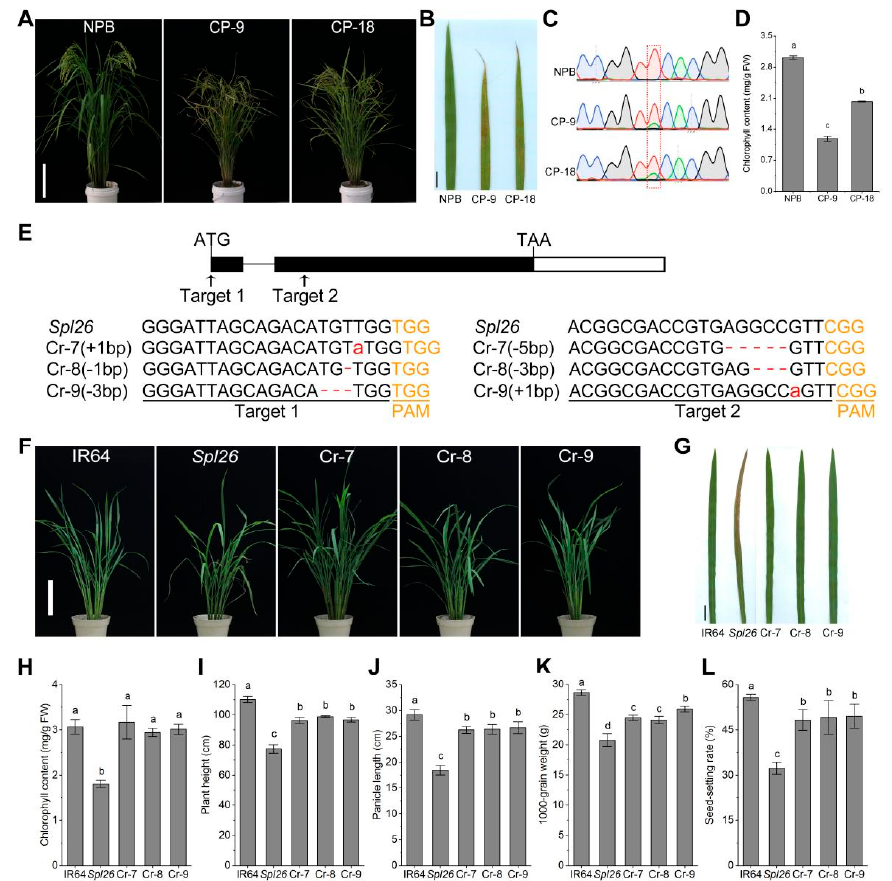
Figure 1. Reverse functional complementation and characterization of reverse complementary and knockout lines. ( A ) Phenotypes of wild-type Nipponbare (NPB) and reverse complementary lines CP-9, CP-18 at the heading stage. Bar = 17 cm; ( B ) Leaf phenotype of NPB and reverse complementary lines. Bar = 2 cm; ( C ) Genotype of NPB and reverse complementary lines CP-9, CP-18. The red box represents the mutation site, NPB has a single red peak (T), both CP-9 and CP-18 have a red/green double peak (T/A). Red peak indicates T, Blue peak indicates C, Green peak indicates A, Black peak indicates G; ( D ) Chlorophyll content of NPB and reverse complementary lines CP-9, CP-18 at the tillering stage; ( E ) CRISPR/Cas9-mediated mutations at the target sites in representative knockout lines (Cr-7, Cr-8 and Cr-9), small red letters indicate the corresponding base insertions, dot lines indicate deletions; ( F , G ) Phenotypes of IR64, Spl26 and knockout lines Cr-7, Cr-8, Cr-9 at the tillering stage. ( F ), Bar = 18 cm. ( G ), Bar = 2 cm; ( H ) Chlorophyll content; ( I – L ) Major agronomic traits. Data are means ± SD ( n = 3). Different letters indicate significant differences at p < 0.05 by Duncan’s multiple test.